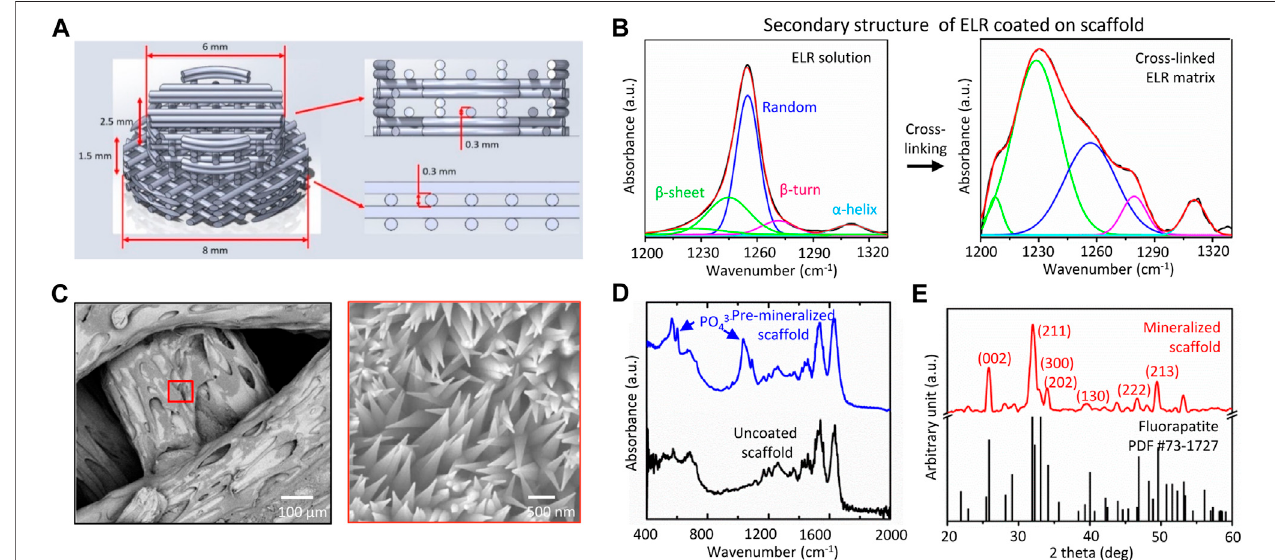
FIGURE 1 | (A) Architecture of 3D printed nylon scaffold, (B) FTIR spectra showing the transition of secondary structure of the ELR from disordered (random) to ordered ( β -sheet) due to solvent evaporation and crosslinking, (C) SEM micrographs showing mineralized structures with needle-shaped topography emerging after 14 days of scaffold mineralization, and physical characterization of the mineralized coating using (D) FTIR, and (E) XRD indicating formation of apatite